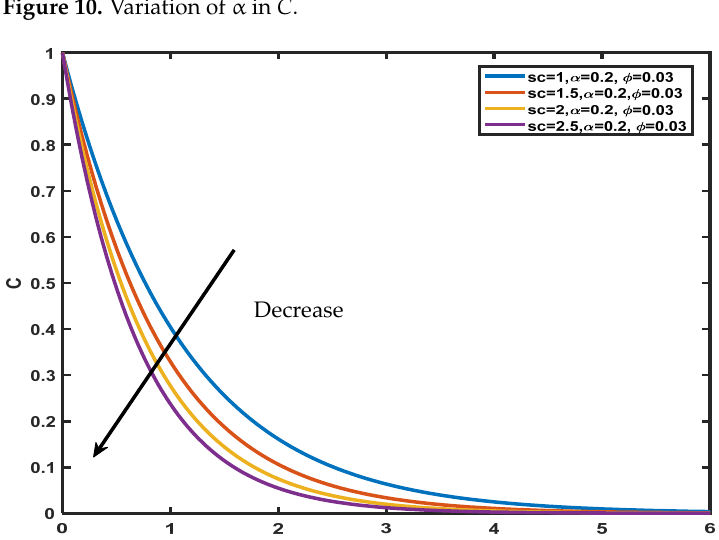
Figure 10. Variation of α in C .